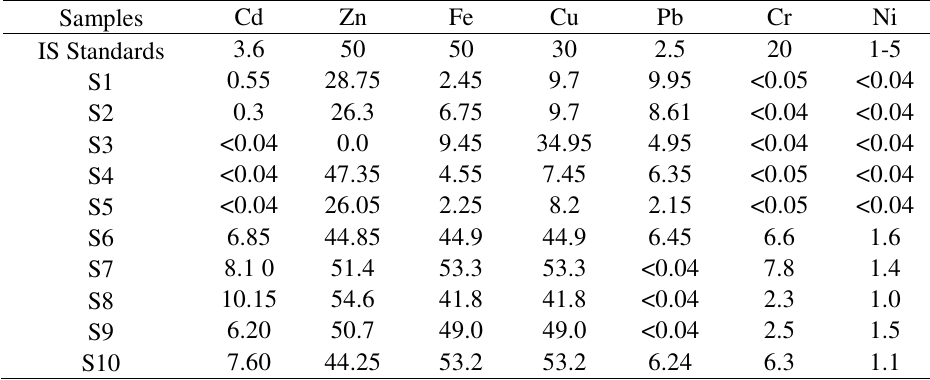
Table 5. Heavy metals (mg/kg of dry wt) in random samples of cabbage collected from fields around the lakes of